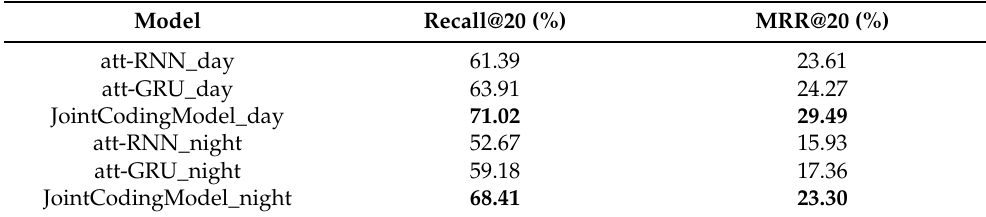
Table 6. Experimental results of day–night group.